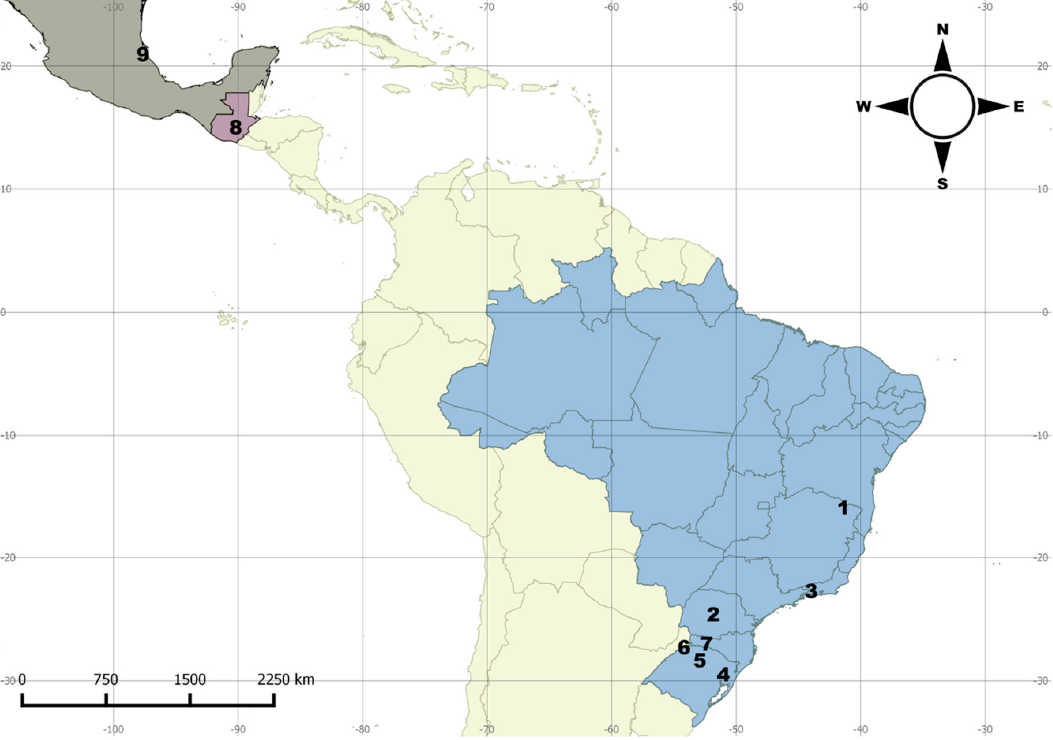
Figure 6. Distribution map for Mycotretus centralis Arrow, 1909 species. Brazil (1–7): 1—Pedra Azul (MG); 2—Pitanga (PR); 3—Piraí (RJ); 4—Campo Bom, 5—Carazinho, 6—Derrubadas (RS); 7—Nova Teutônia (SC). Guatemala: 8—San Jerónimo. Mexico: 9—Tuxpan, Vera Cruz.